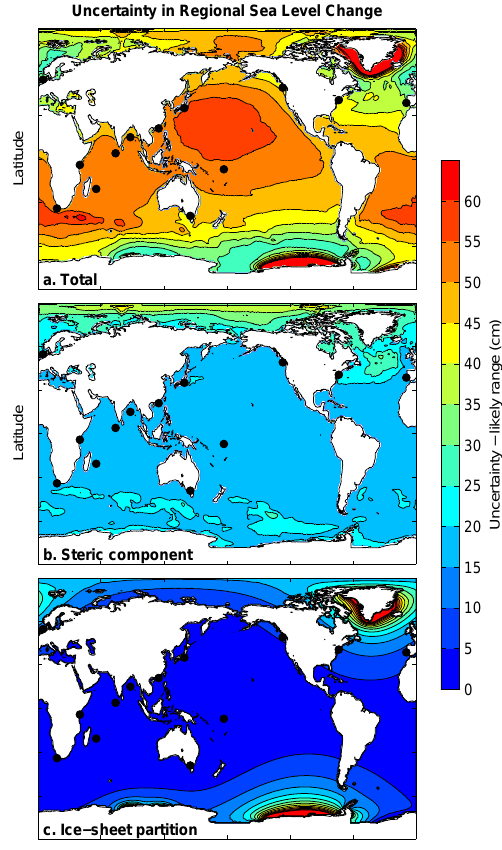
Fig. 12. (a)–(c) Uncertainty in regional sea level change, indicated as “likely” range (roughly 16th to 84th percentiles). Uncertainty in sea level change (a) and its steric component (b) , for the RCP 4.5 scenario in the semi-empirical case. The uncertainty resulting from GIS/AIS partition in the semi-empirical approach is illustrated in panel (c) , for a total ice sheet contribution equal to the ensemble median. Contours lines indicate 5cm intervals. Black dots indicate individual locations highlighted in Fig.